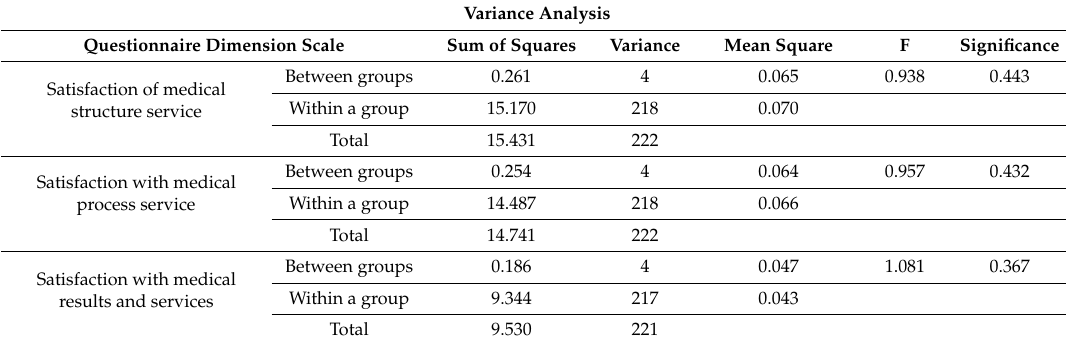
Table 25. Analysis of Monthly Disposable Income and Scale Dimension